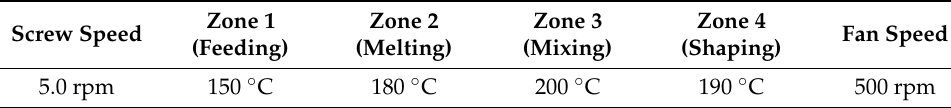
Table 2. Filament extrusion process